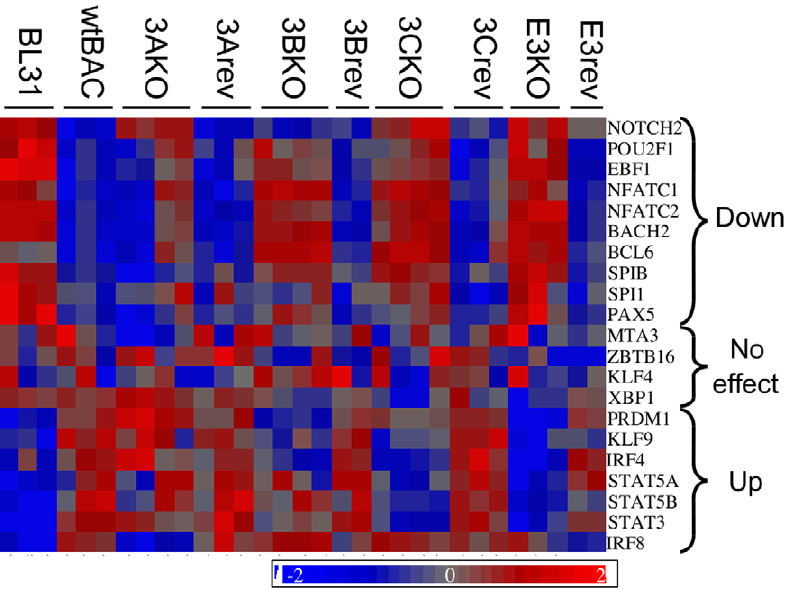
Figure 4. EBV and EBNA3s alter the expression of B-cell differentiation-related transcription factors. Heat map shows the relative expression levels of key transcription factors involved in B-cell differentiation. MMBGX-extracted gene expression levels were normalised to the mean and scaled by the standard deviation of the gene expression level for each gene – colour scale ranges from + 2 to 2 2 standard deviations. Genes are grouped according to whether they are up- or down-regulated upon infection by EBV. Those not significantly altered are also indicated. Fold change and ANOVA contrast p values for these genes are shown in Figure S2.